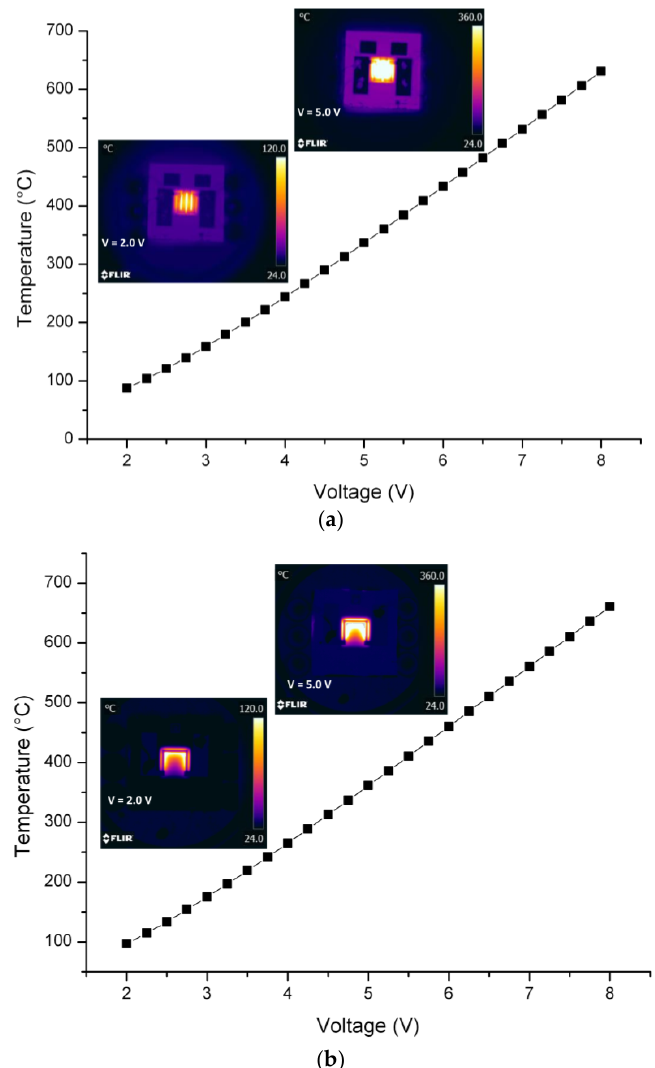
Figure 11. Comparison between the temperature variation of the resistor as a function of the input voltage as from the model and thermography characterization on the device for the buried ( a ) and coplanar ( b ) design.